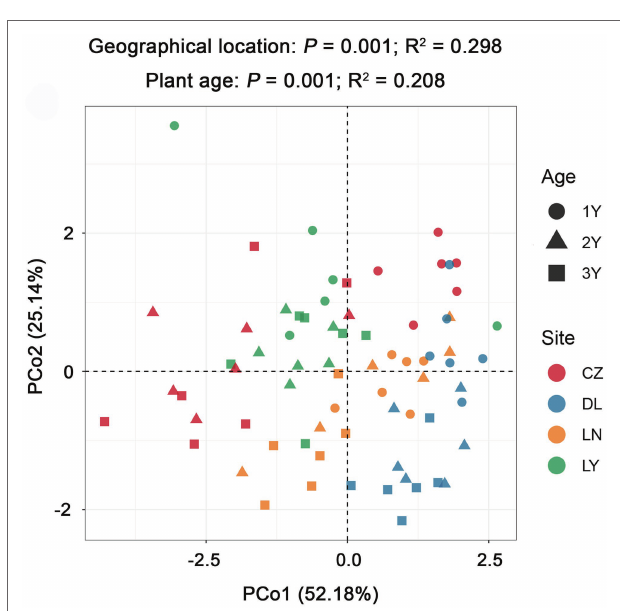
FIGURE 4 | Variation in the root alkaloid accumulation of S. flavescens performed by principal coordinate analysis (PCoA) based on the Bray-Curtis distance matrix. LN: Lingyuan; CZ: Changzhi; DL: Dali; LN: Luonan. 1Y: 1-year-old; 2Y: 2-year-old; 3Y: